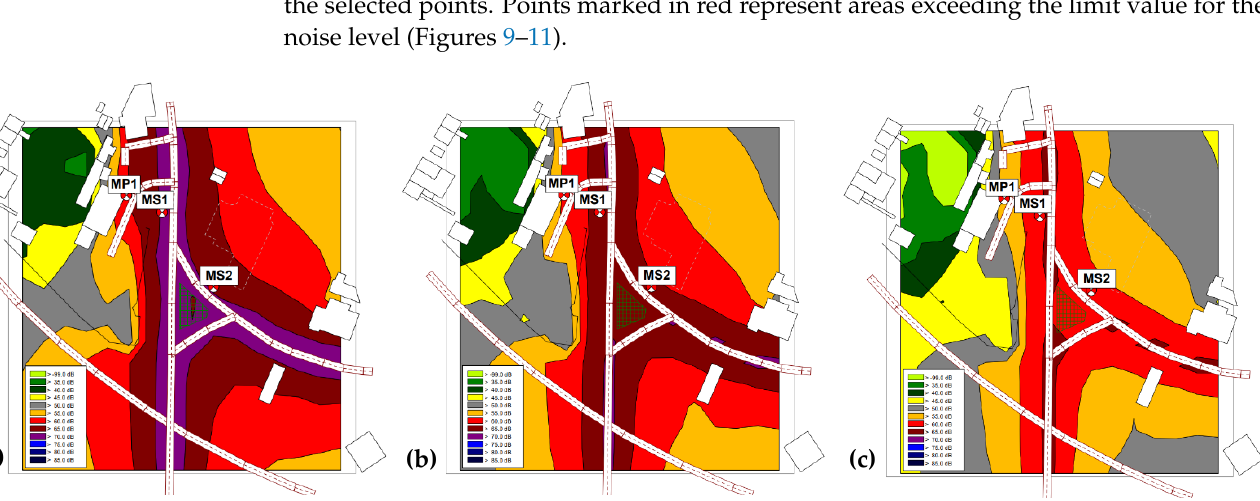
Figure 9. Model of the spreading of noise emissions from road traffic in the vicinity of the original three-arm intersection in the city of Žilina (T_16) during the ( a ) daytime, ( b ) evening and ( c ) night-time.